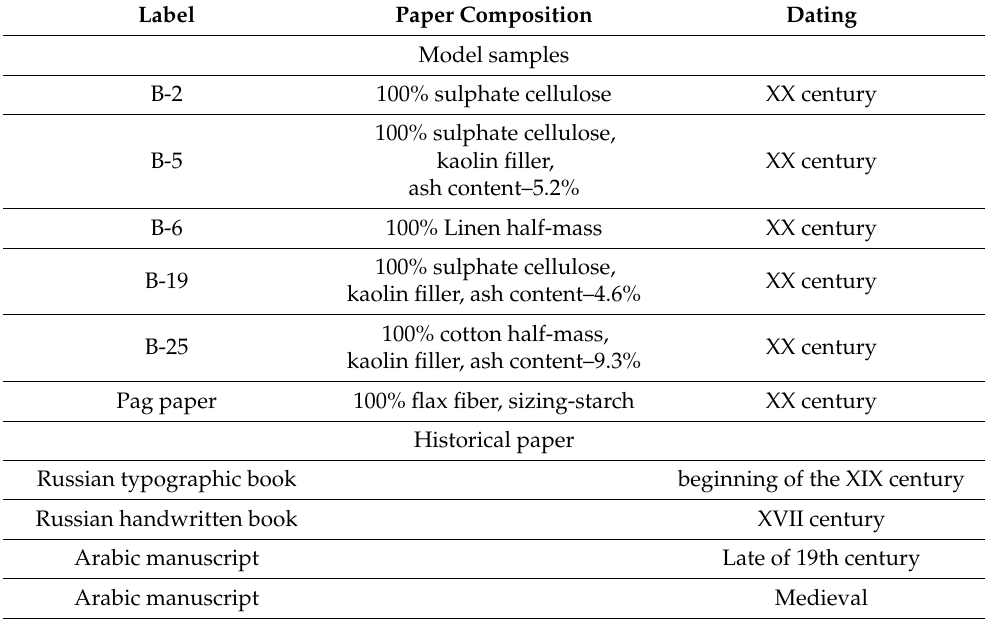
Table 1. List of samples. Label Paper Composition